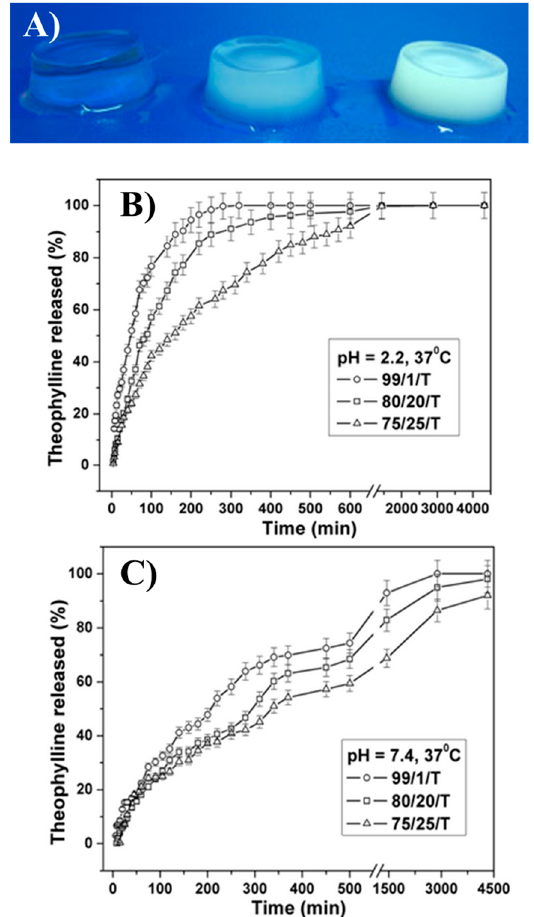
Figure 19. ( A ) Photographs of PNIPAAm-alginate IPN hydrogels; and ( B , C ) theophylline release profiles of distinct concentrations of sodium alginate on PNIPAAm hydrogel at pH 2.2 and pH 7.4, respectively. Reprinted with permission from Reference [110] and Reference [74], for (A) and (B,C), respectively. Copyrights © 2010 Society of Chemical Industry and © 2014 Wiley Periodicals Inc. (Seoul, Korea), respectively.